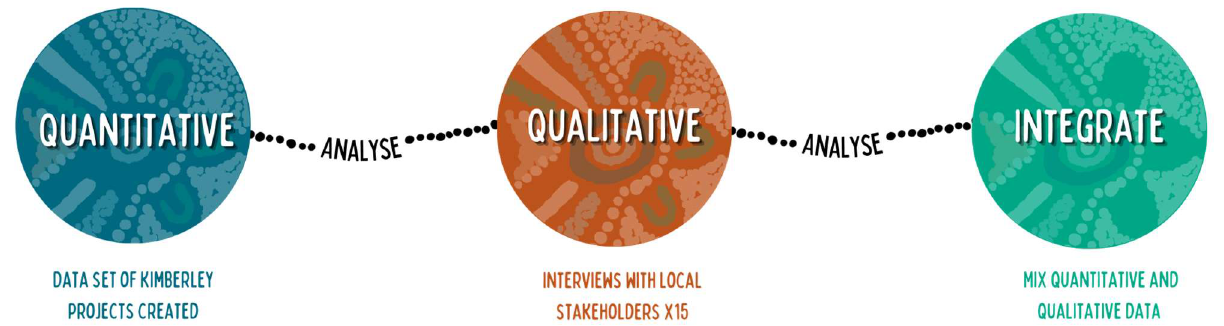
Figure 1. Diagram of explanatory sequential mixed methods .